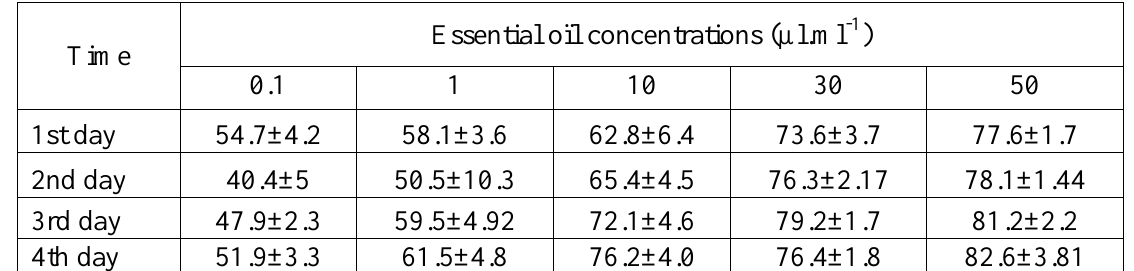
Table 2. Antifungal activity of Artemisia herbaalba essential oïl against fungal